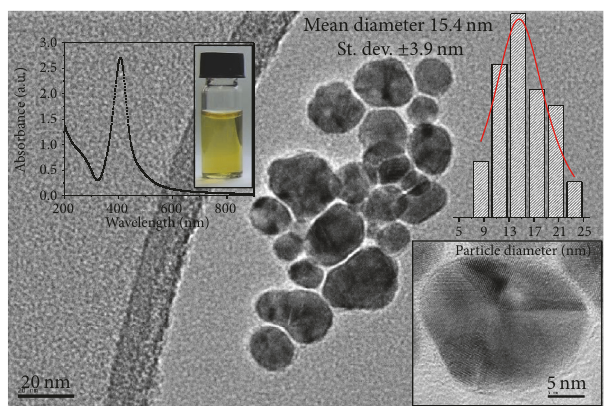
Figure 1: TEM image of starch-stabilized silver nanoparticles; insets: UV-Vis absorption spectrum and digital photographs (left), high-resolution TEM image of single nanoparticles, and histogram of nanoparticle size distribution